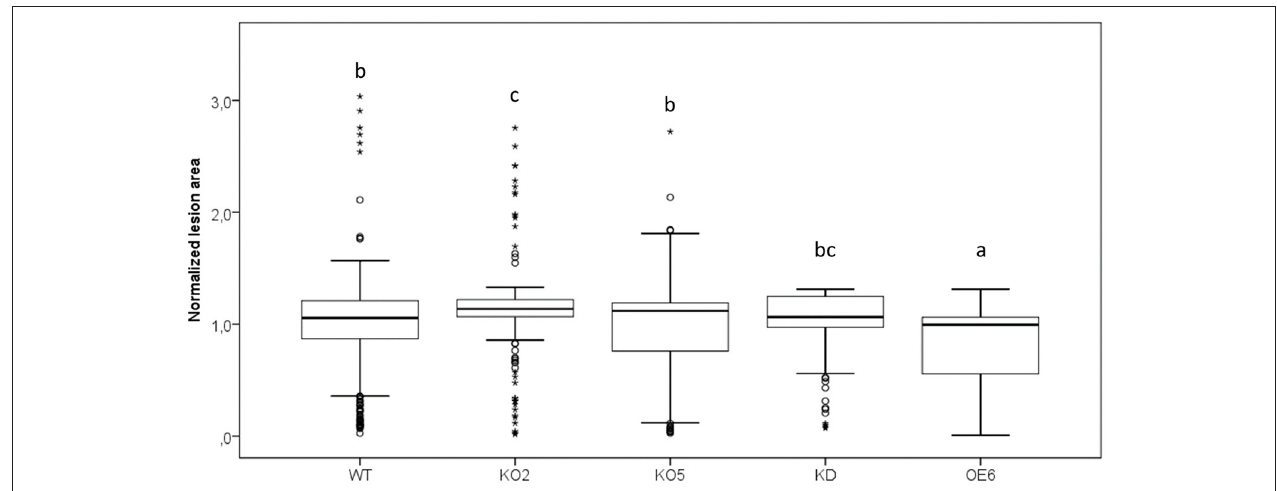
FIGURE 5 | Quantification of damaged leaf area after Pst DC3000 infection in WT, KO2, KO5, OE6, and KD plants. Leaf damage was measured as chlorotic lesion area in total leaf area and normalized to the WT lesion area. These results are based on three independent biological replicates. For this graph, values of all plant lines were normalized to the WT of each experiment, allowing us to represent two different experiments together in one graph. Comparison of Arabidopsis lines was done with a one-way ANOVA analysis followed by a post hoc Tukey test. Significant letters indicate differences at a level of p < 0.05.